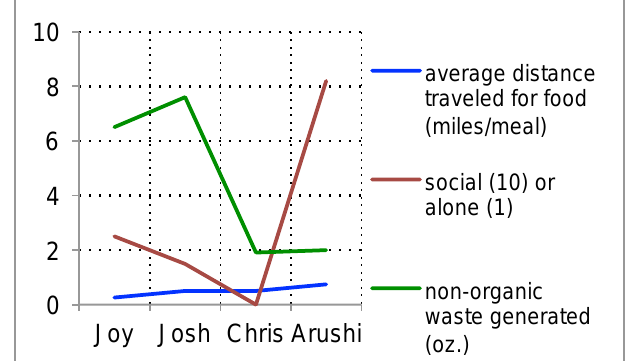
Figure 6 : Graphic representation of all four subjects relative to distance per meal travelled, social engagement while eating and the non-organic weight generated in ounces. The parameters of mobility (average distance travelled) and meals as social or work events (social vs. alone) are measured against the amount of non-organic waste from food that each subject